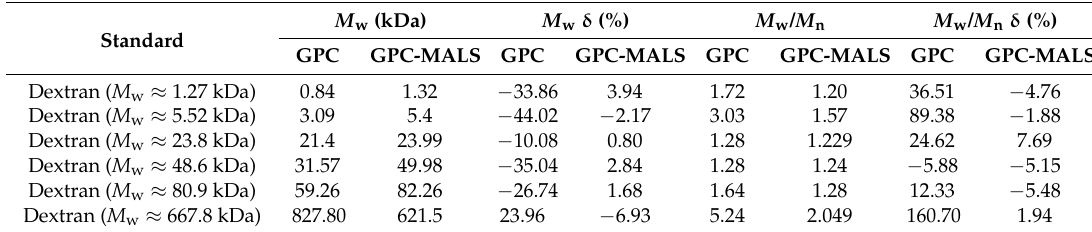
Table 5. Error analysis of GPC and